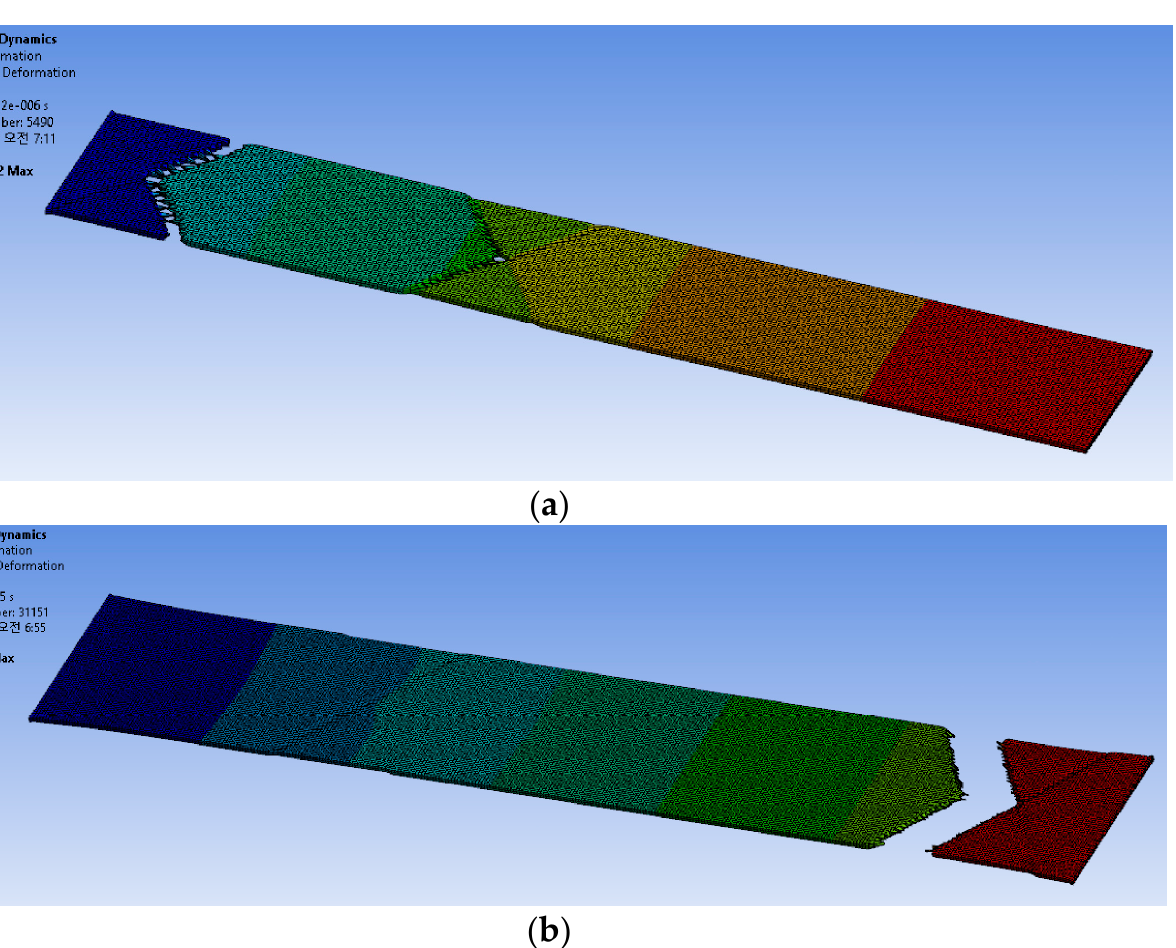
Figure 9. Stress-strain curves depending on the sample thickness. ( a ) FPCB. ( b ) PSPI.